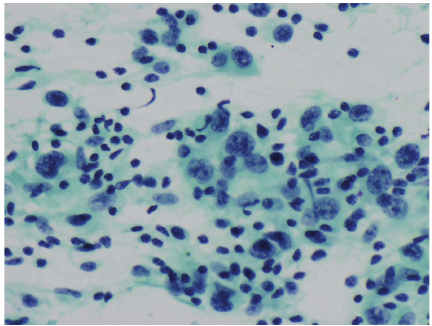
Figure 2: FNAC demonstrating undi ff erentiated pleomorphic tum- our cells in addition to lymphocytes and histiocytes (Pap. × 400).